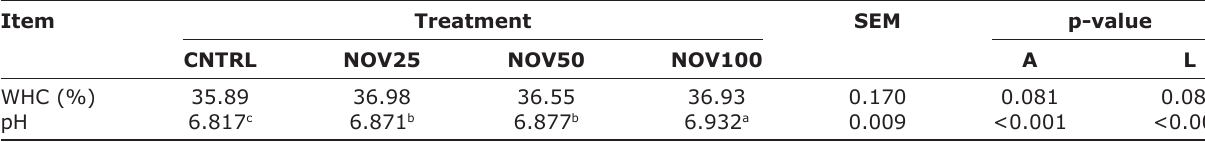
Table-5: Water-holding capacity and pH values of broiler meats. Item